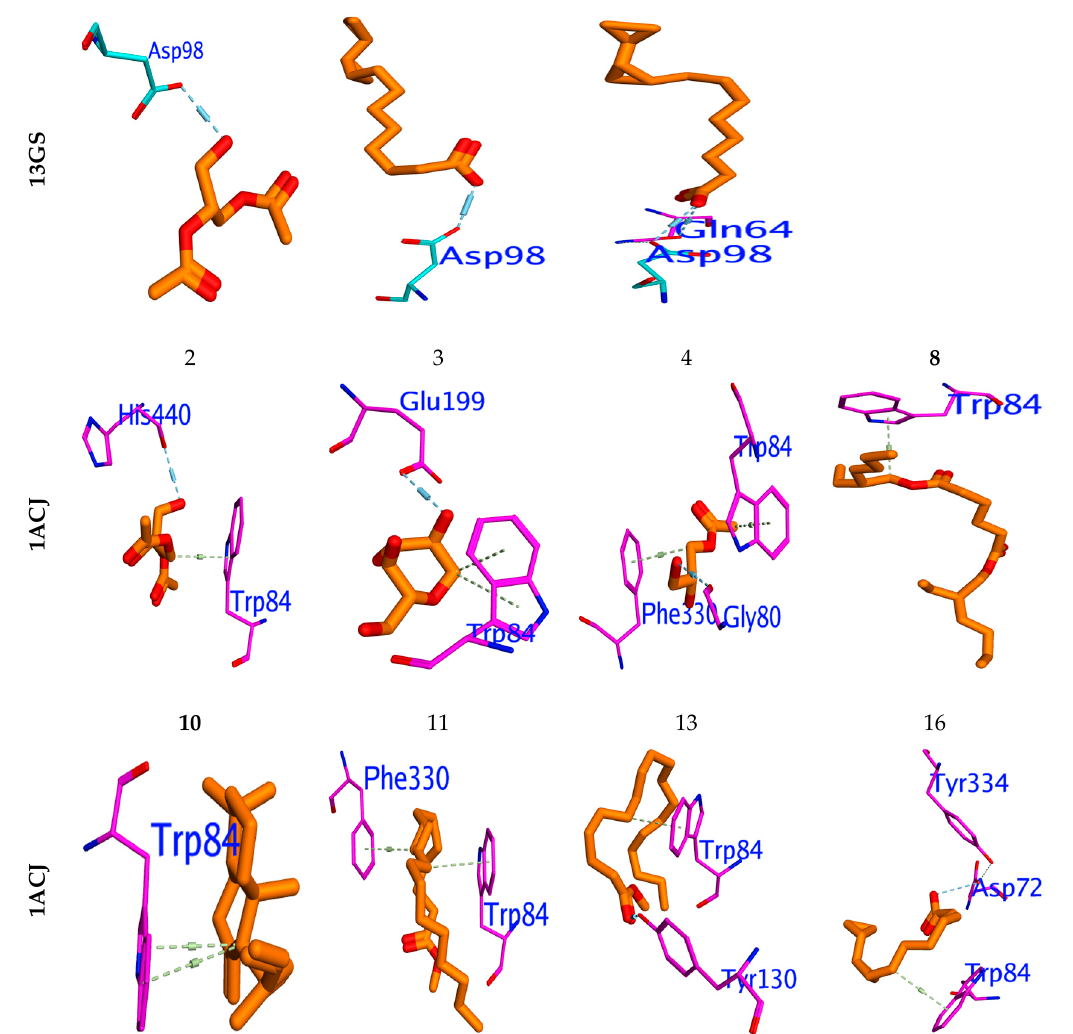
Figure 4. Binding mode for metabolites with the highest expected sharing in antibacterial (6M1J), antioxidant (13GS), and acetylcholinesterase “AChE” (PDB ID: 1ACJ activity.